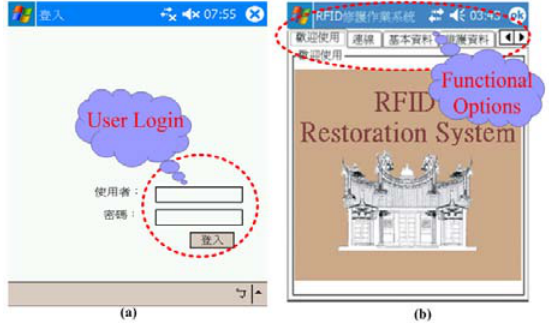
Fig. 10. User login page (a); main page (b)